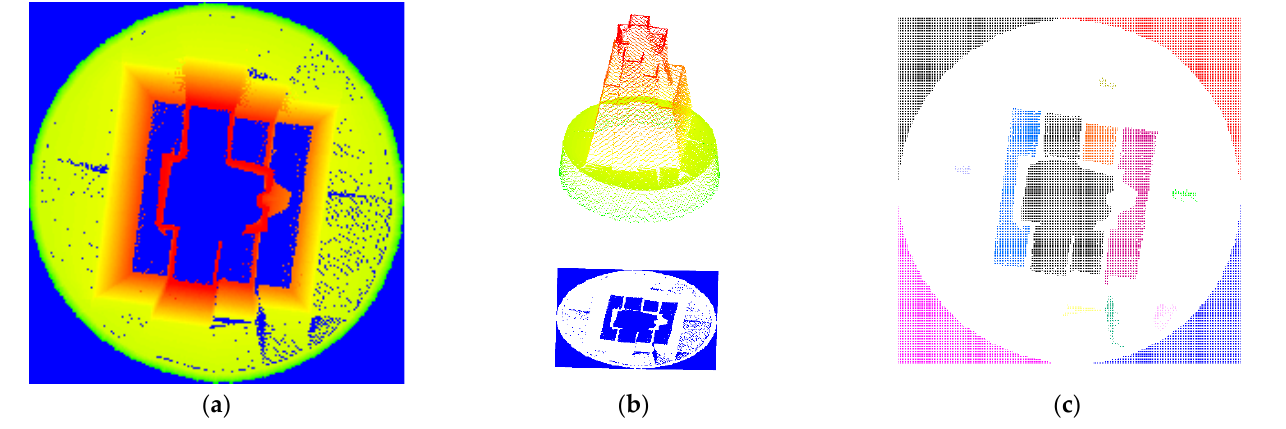
Figure 19. TLS point cloud hole data acquisition. ( a ) Point cloud rasterization. ( b ) A cell center